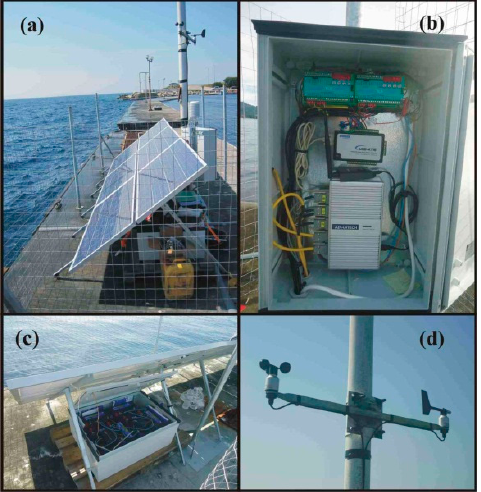
Figure 1. ( a ) Solar panels; ( b ) Industrial computer of SNMR; ( c ) Energy storage batteries; ( d ) Wind speed and wind direction sensor.